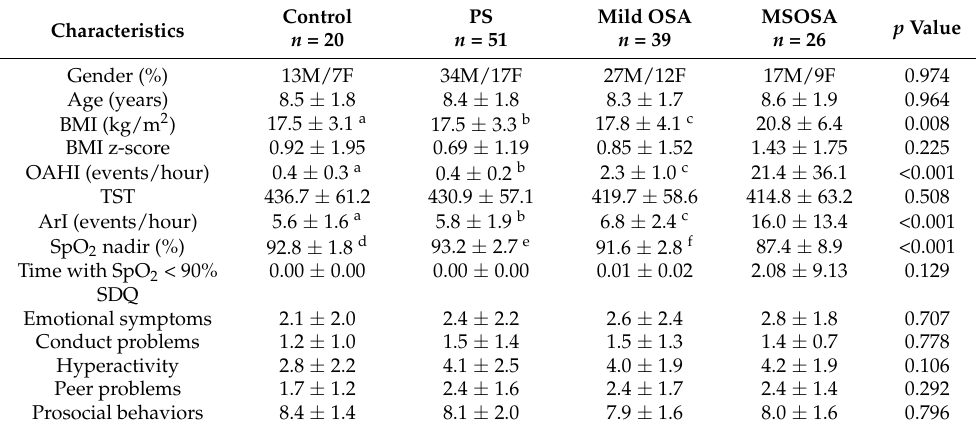
Table 1. Clinical and polysomnographic characteristics of